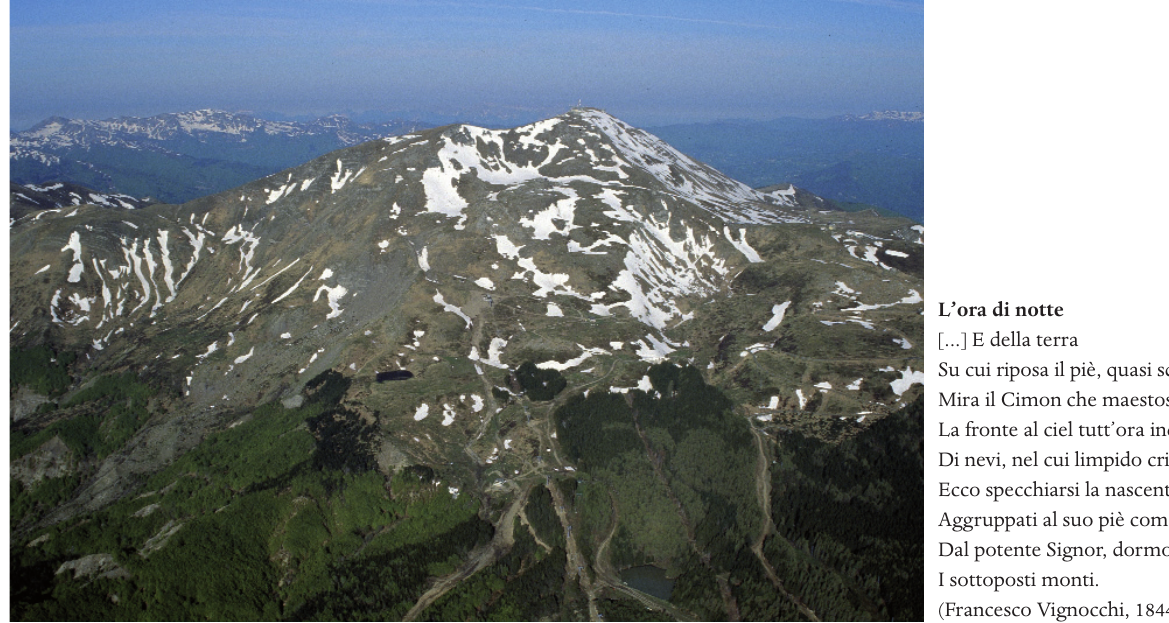
Figure 4. The poetry and landscape of Monte Cimone (2.165 m), the highest peak in the northern Apennines (Photo G.